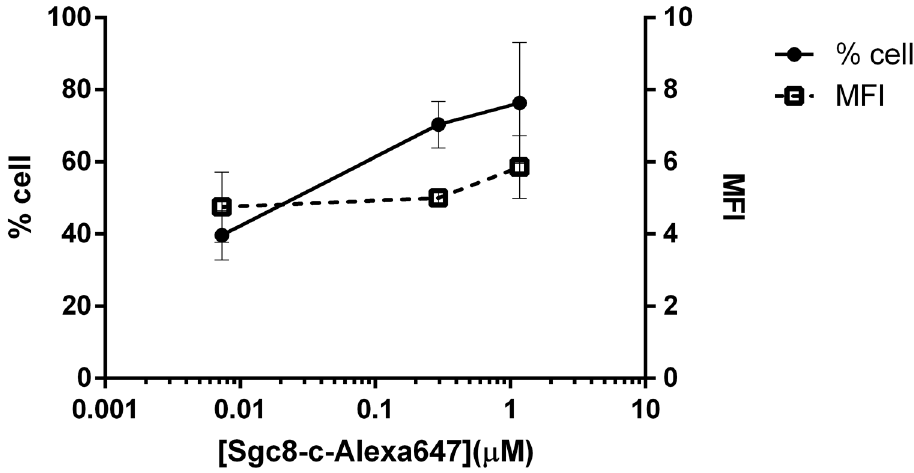
Figure 3. Flow cytometry of B16F10 cell line treated with Sgc8-c-Alexa647. Percentage of positive cells and specific MFI after incubation with the fluorescent probe.